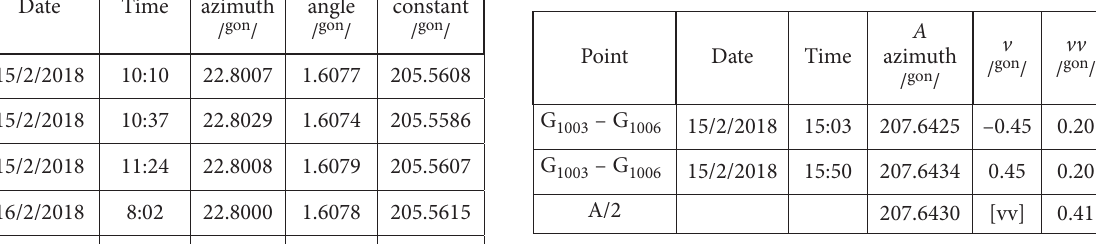
Table 10. Recorded azimuths A and corrections